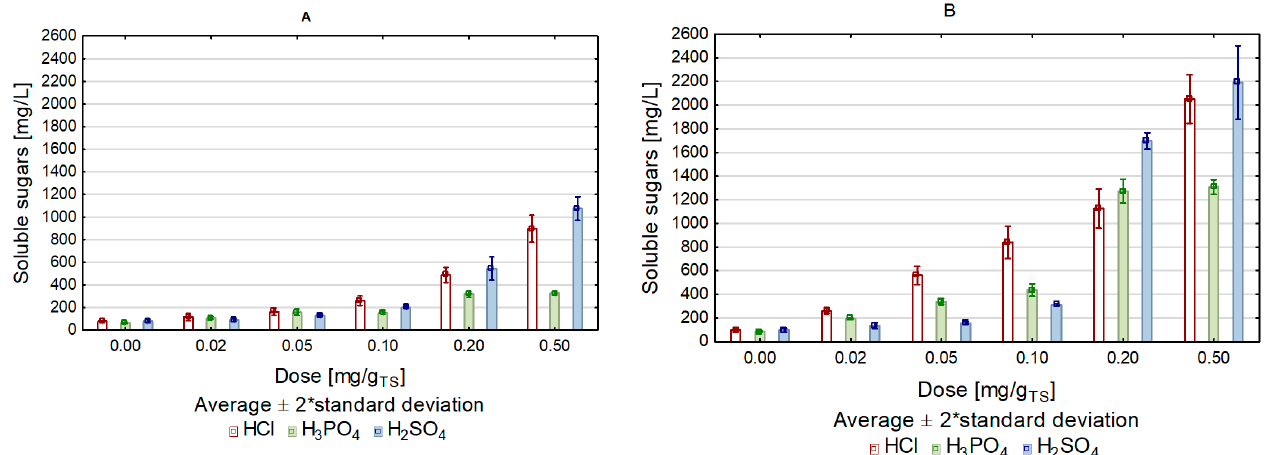
Figure 2. Content of soluble sugars depending on the heating method and acid dose (( A )—conventional, ( B )—microwave).